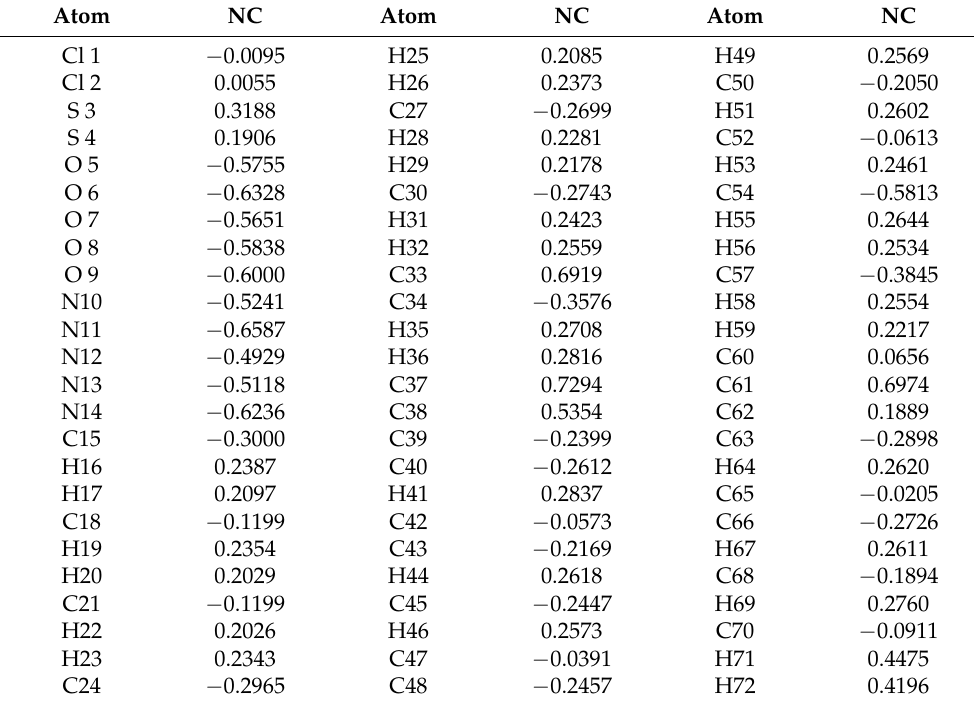
Table 6. Natural charge (NC) population of 5a a .